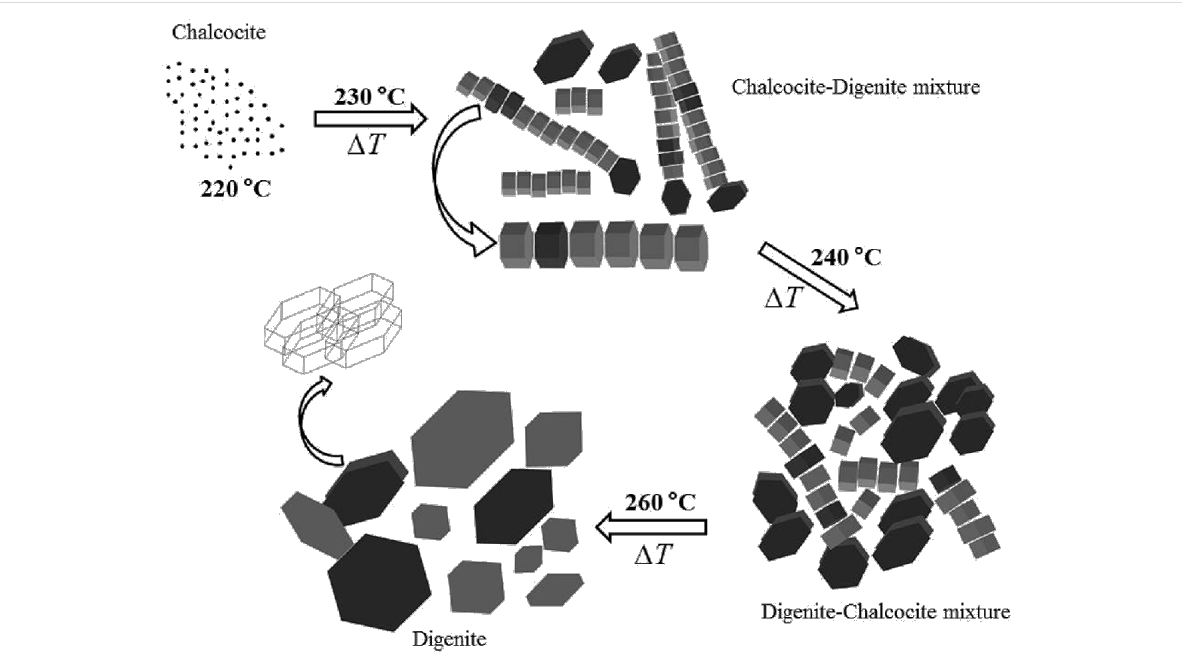
Figure 8: Scheme of the phase-transition mechanism from chalcocite to digenite and the formation of the respective nanocystals of the Cu x S samples as a function of the temperature. The growth of the crystalline digenite begins with the formation the nanoparticles at 220 °C and it ends at 260 °C.